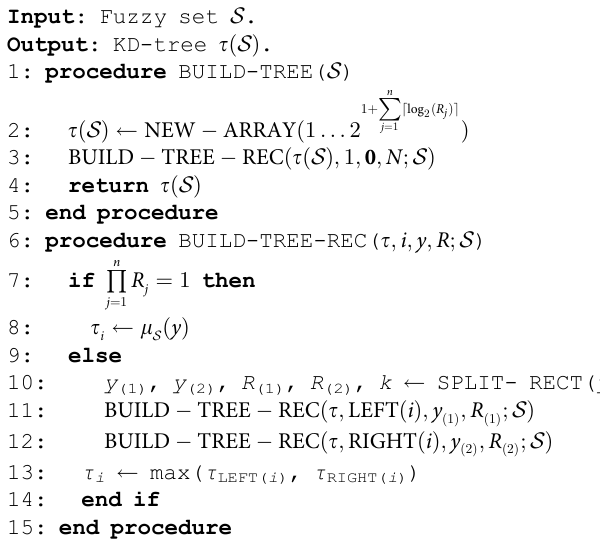
Algorithm 3 constructs an augmented KD-tree [34], t ð S Þ , that corresponds to the input image S . Within each node of t ð S Þ we store the maximum intensity of that sub-tree. This enables an efficient distance search, where sub-trees which are empty after α -cutting can be pruned. The discrete rectangular domain enables storing the node attributes compactly in a single array. The left and right sub-trees of a node indexed by i have indices 2 i and 2 i + 1 respectively, where the root has index